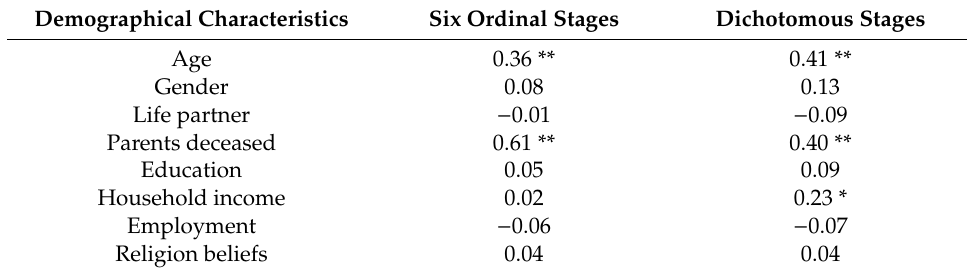
Table 4. Correlation matrix of demographical variables and stages of readiness for